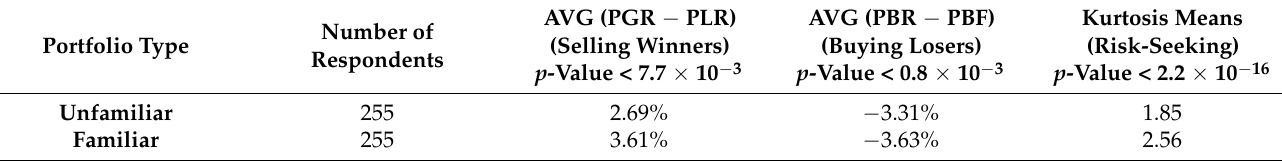
Table 1. Experimental